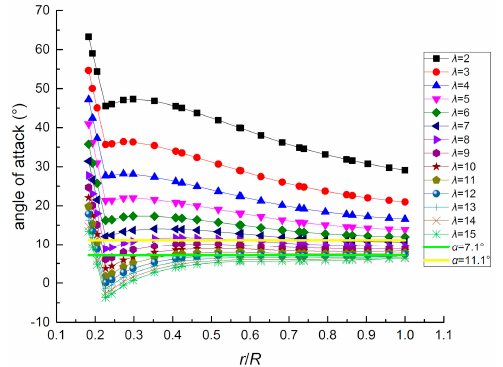
ff erent tip speed